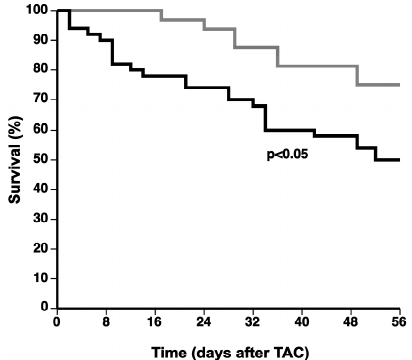
Figure 1. Kaplan–Meier survival curves during an eight weeks follow-up period after TAC. Female C57BL/6 mice on SC diet (grey line) or CC diet (black line) are compared. The Day 0 time-point corresponds to TAC intervention at the age of 17 weeks. Survival analysis was performed by log-rank test.